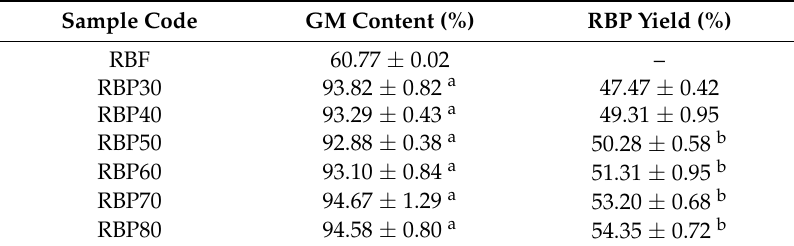
Table 1. Glucomannan (GM) content and yield of